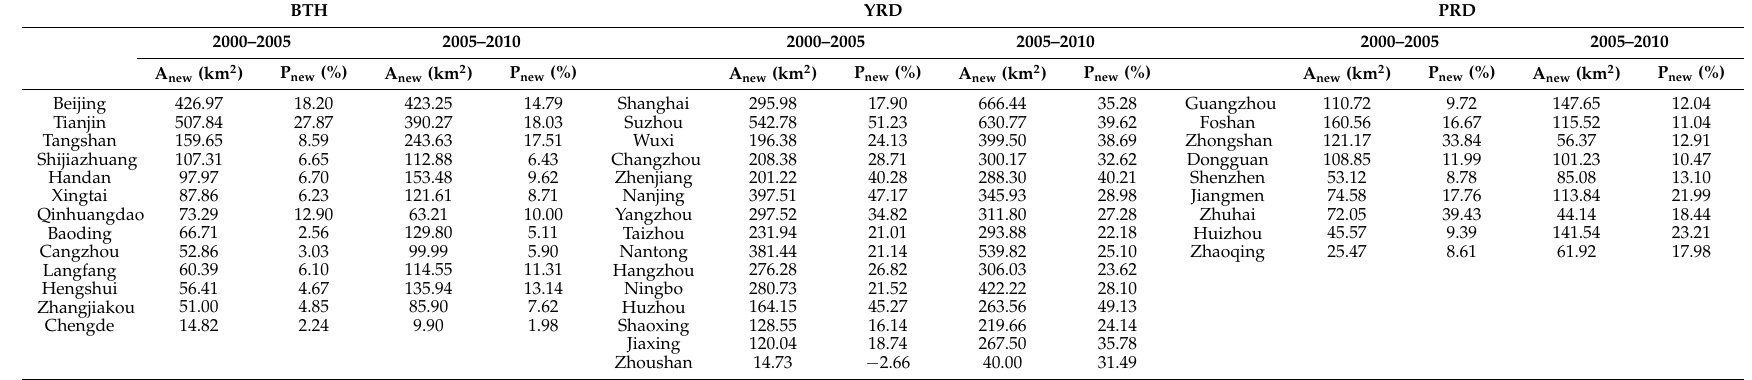
Table 5. The area of newly developed land (A new ) and its ratio to the previously existing developed land (P new ) of the cities in the three urban